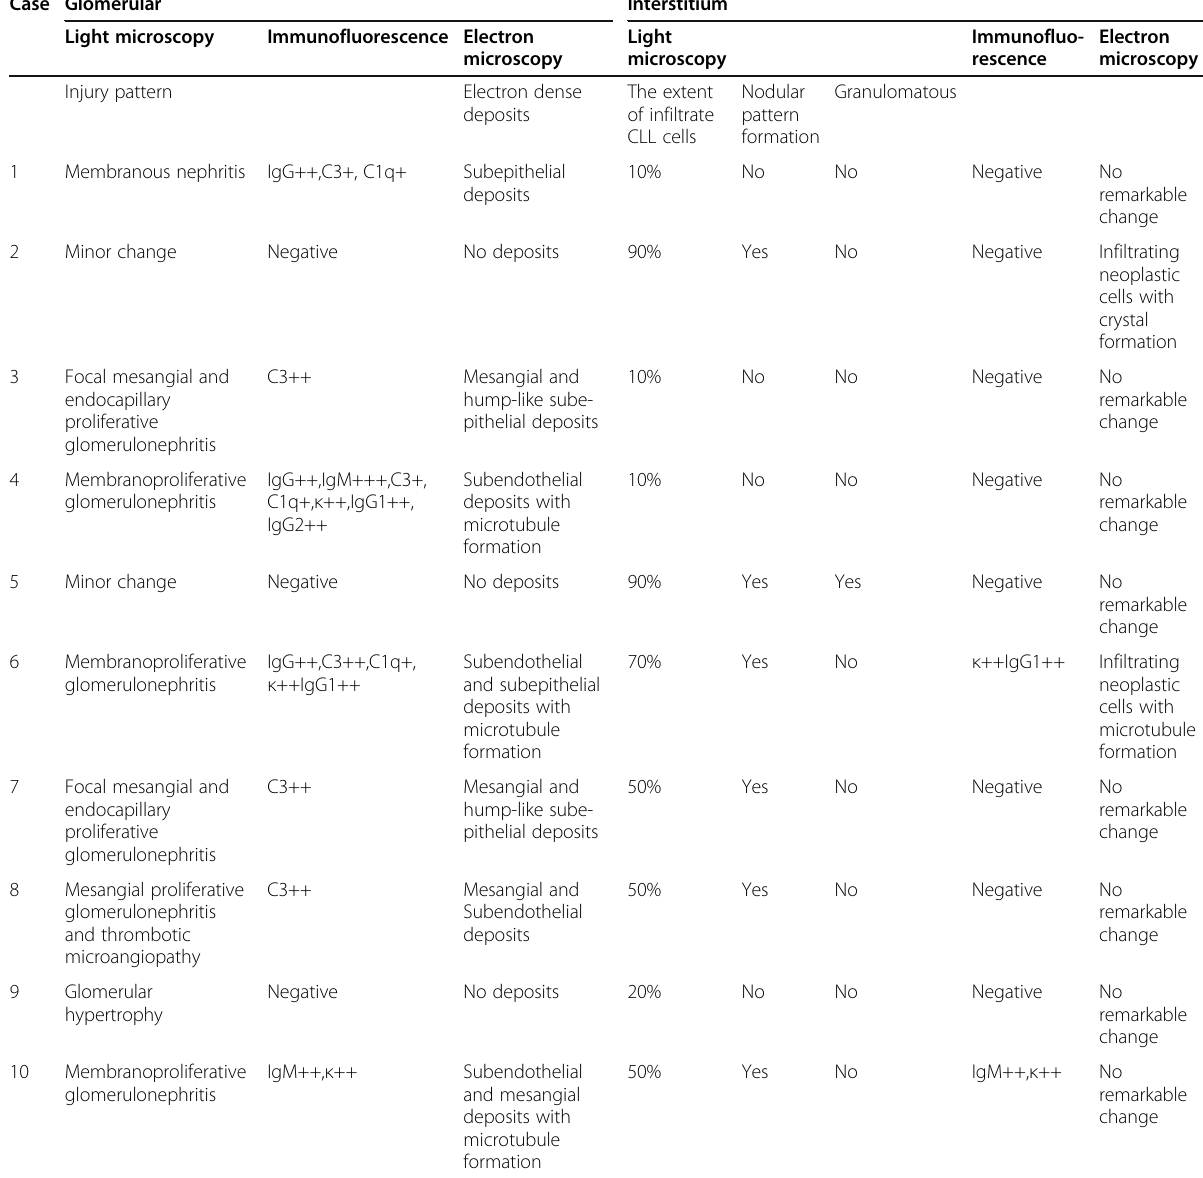
Table 2 The kidney biopsy pathology and characteristics of the interstitial infiltrating CLL cells Case